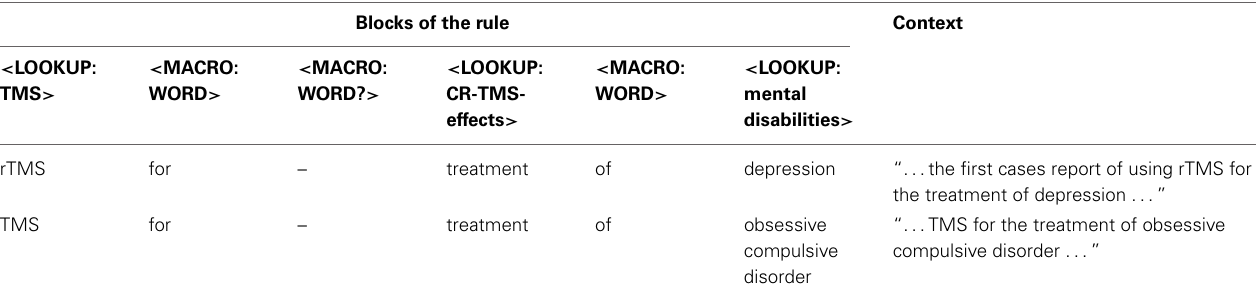
Table 5 | Example sentences retrieved with BioRAT using a specific rule. Blocks of the